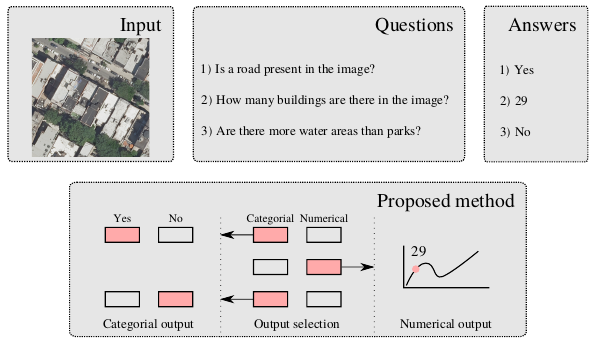
Figure 1. Schematic illustration of the proposed